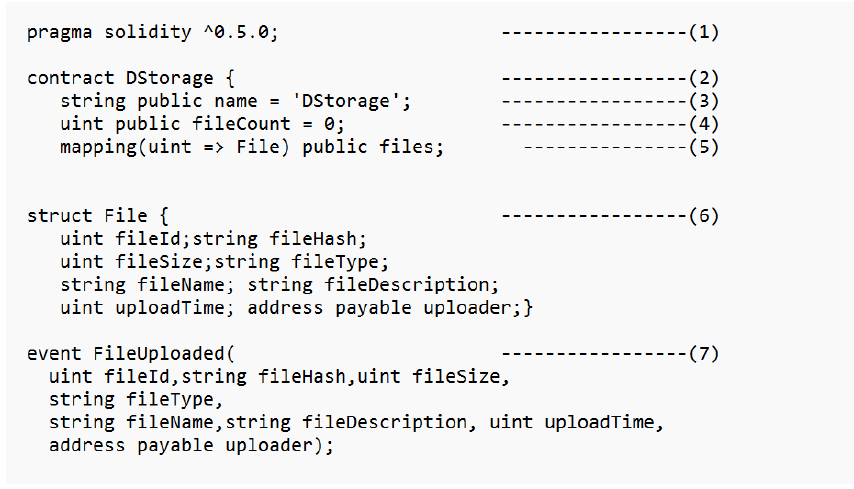
Figure 3. Solidity code for creation of a blockchain register and events to facilitate interoperability (1/2).